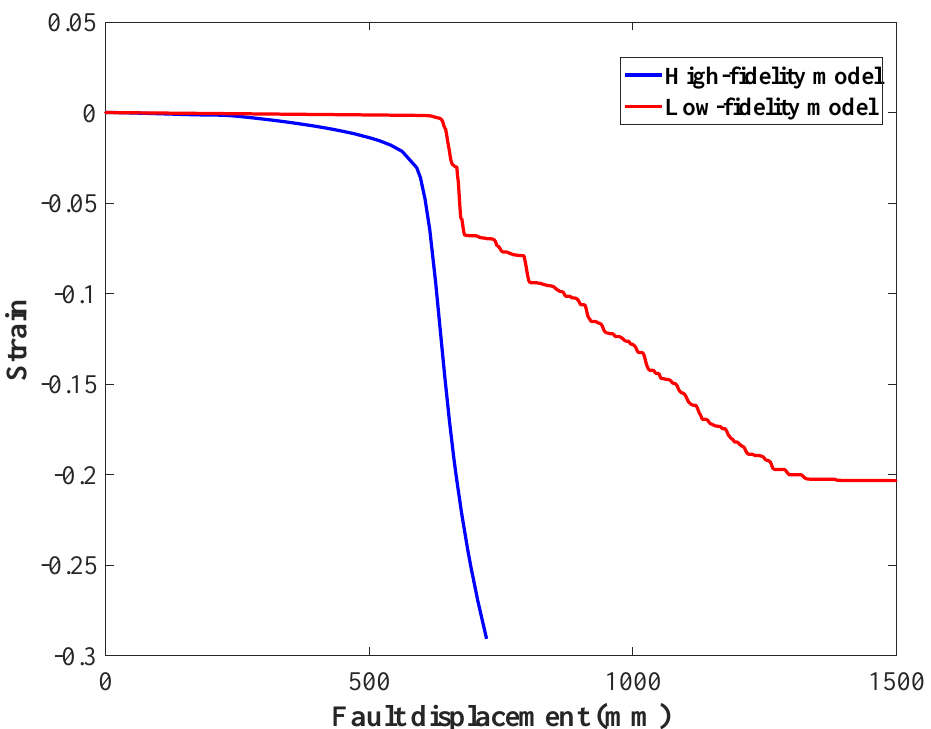
Figure 4. Sample peak compressive strain vs. fault displacement comparison between high-fidelity and low-fidelity